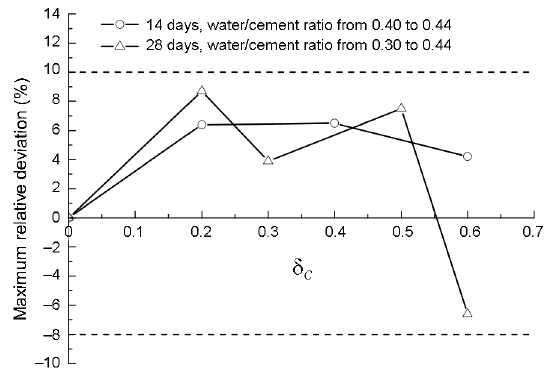
Figure 8. Influence of mix proportions of concrete on stress influence coefficient under compressive